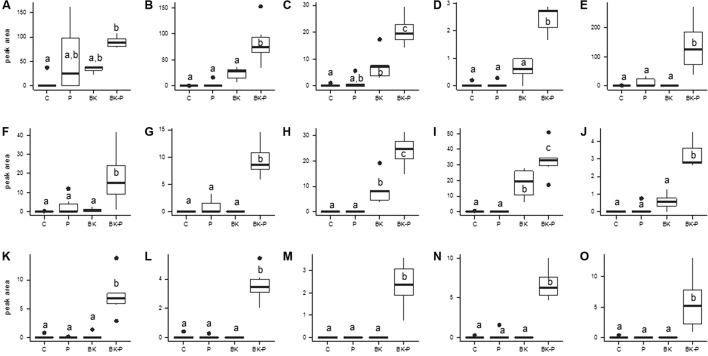
Markers from the different root exudates from sand culture which were more abundant in the buckwheat/pigweed mixed culture. Root exudates obtained from 11 days old sand cultures of control boxes without plants (C), with pigweed (P), with buckwheat (BK) and with a buckwheat/pigweed mixed culture (BK-P) and analyzed by UHPLC-HRMS. A selection of markers were identified as L-Tryptophan (A) and tentatively identified as Fructose-Leucine or Fructose-Isoleucine (B), Fructose-Phenylalanine (C), C13H19NO7
(D), C14H20O7
(E), N-acetyl glutamic acid methyl ester (F), a sulfur-containing compound C14H34O10S (G), C25H33N3O7
(H), C12H13NO6
(I) and C5H10O3
(J). The following markers are unidentified with the respective retention time and m/z of 1.696; 365.135 (K), 0.940; 401.082 (L), 0.958; 660.209 (M), 2.923; 305.106 (N), and 6.919; 297.098 (O). Tukey’s HSD, p-value < 0.05, N = 6.